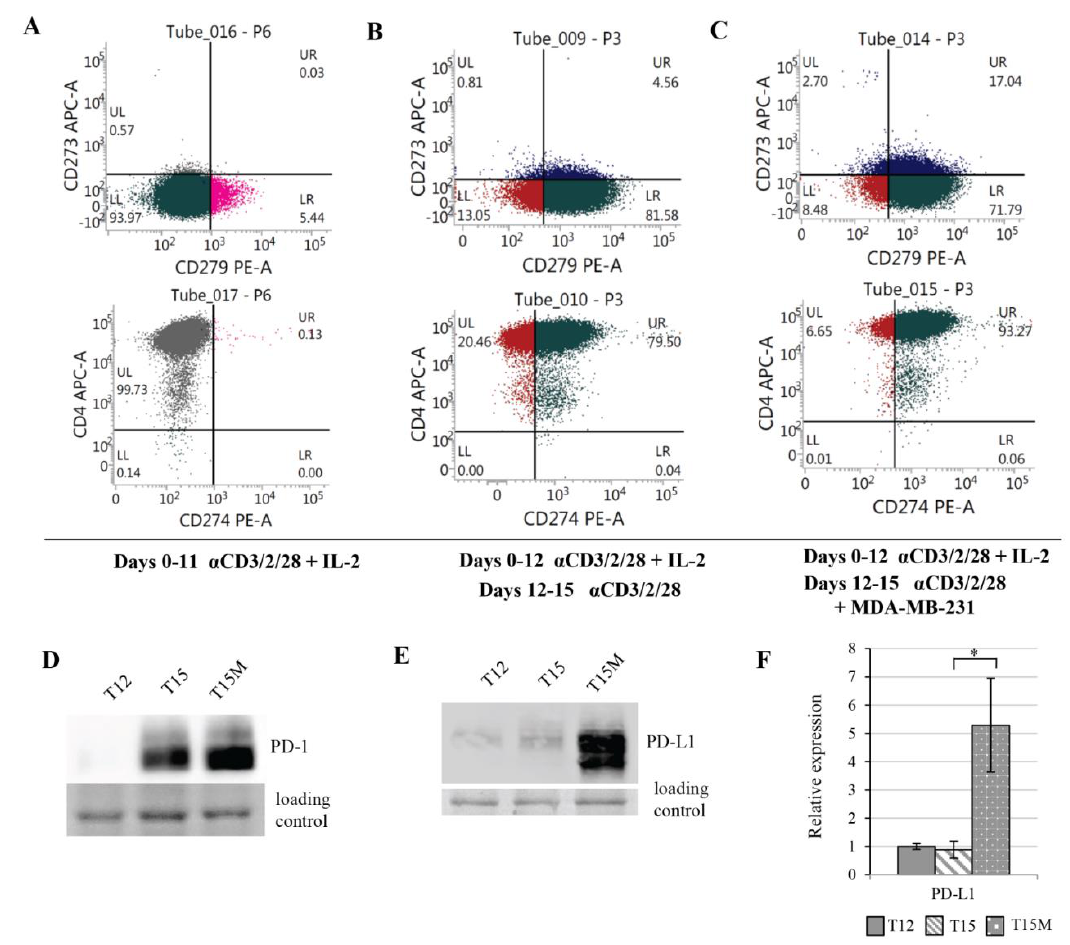
Figure 3. Prolonged polyclonal stimulation induced the expression of PD-1 (CD279), PD-L1 (CD274), and PD-L2 (CD273) in CD3 + CD4 + T cells, which was additionally increased due their exposure to MDA-MB-231 cancer cells. Flow cytometry plots show the expression levels of CD279, CD273, CD274, and CD4 on the surfaces of ( A ) CD4 + T cells activated with anti-CD3/CD28/CD2 moAb-coated stimulatory beads and expanded in the presence of IL-2 (10 U/mL) for 11 days, ( B ) CD4 + T cells expanded with anti-CD3/CD28/CD2 Ab-coated stimulatory beads and with IL-2 (10 U/mL) for 12 days, restimulated on day 12 with anti-CD3/CD28/CD2 Abs without exogenous IL-2 and cultured up to day 15 in the absence of cancer cells, or ( C ) cultured up to day 15 in the presence of MDA-MB-231 cancer cells. ( D ) The protein levels of PD-1 and ( E , F ) PD-L1 were highly increased in CD4 + T cells when restimulation of lymphocytes was performed in the presence of MDA-MB-231 cancer cells. (F) The data from 3 independent biological replicates (donors) are presented, the statistical significance of which was calculated using Student’s t -test p < 0.05. Statistically significant values are indicated by asterisks. The un- cropped blots and molecular weight markers are shown in Supplementary Materials.